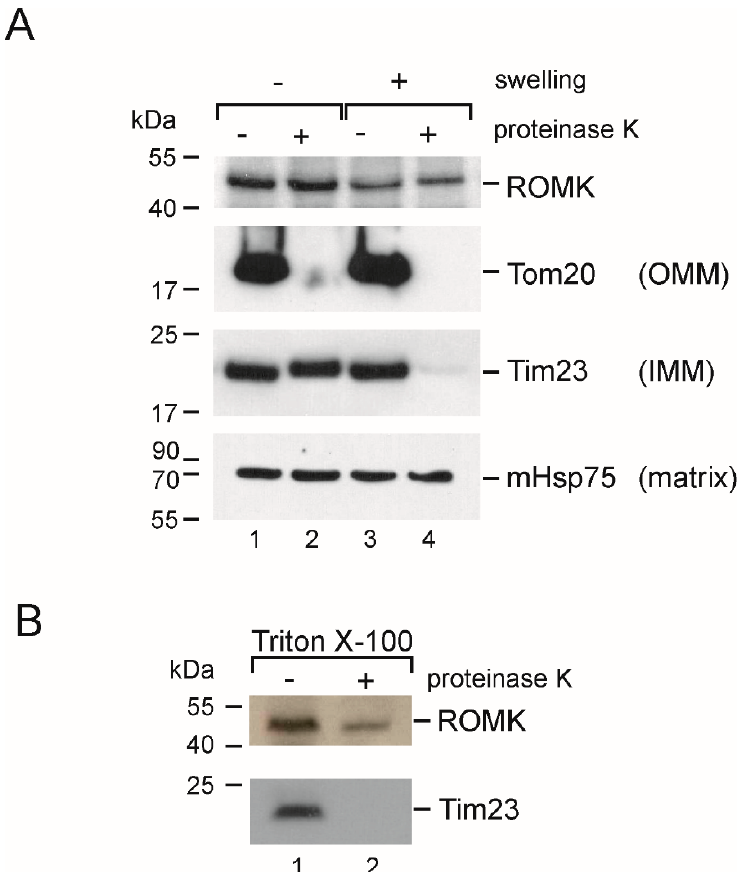
Figure 6. Topology of the mitoK ATP channel from the inner mitochondrial membrane of H9c2 OE ROMK2. ( A ) Western blot analysis after Proteinase K (PK) treatment (OMM—outer mitochondrial membrane; IMM—inner mitochondrial membrane). ( B ) Western blot analysis after the PK treatment of mitochondria solubilized with Triton X-100 (TrX). Each experiment was performed from independent mitochondrial isolation ( n = 5). Each mitochondrial isolation was performed from 25–30 mln cells.